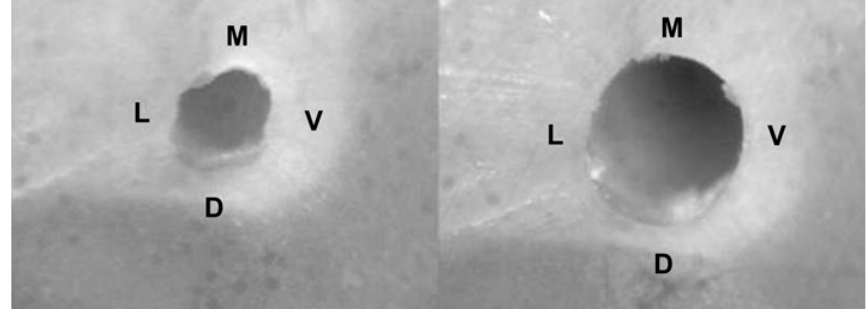
FIGURE 2- Preoperative image (left) and postoperative image (right) showing complete instrumentation of the walls. M, mesial; D, distal; V, buccal; L, lingual